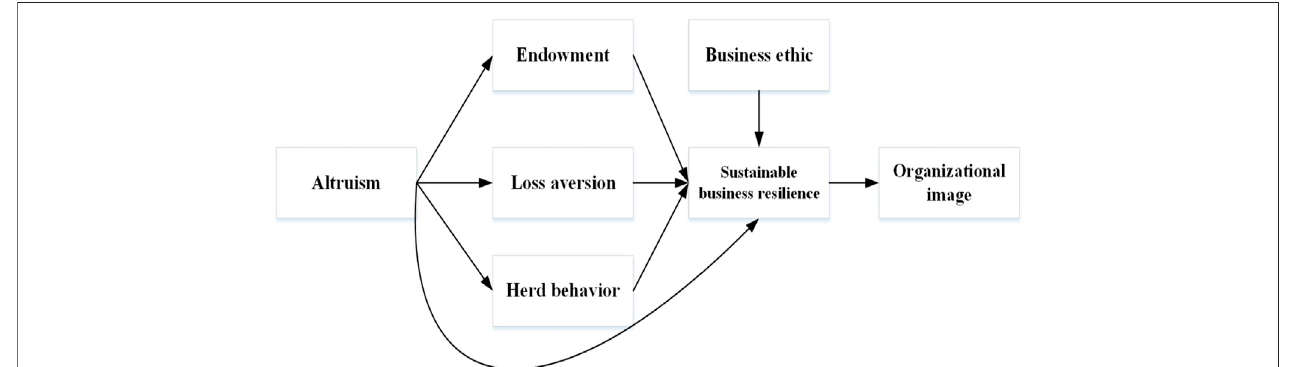
FIGURE 1 | Flow diagram.